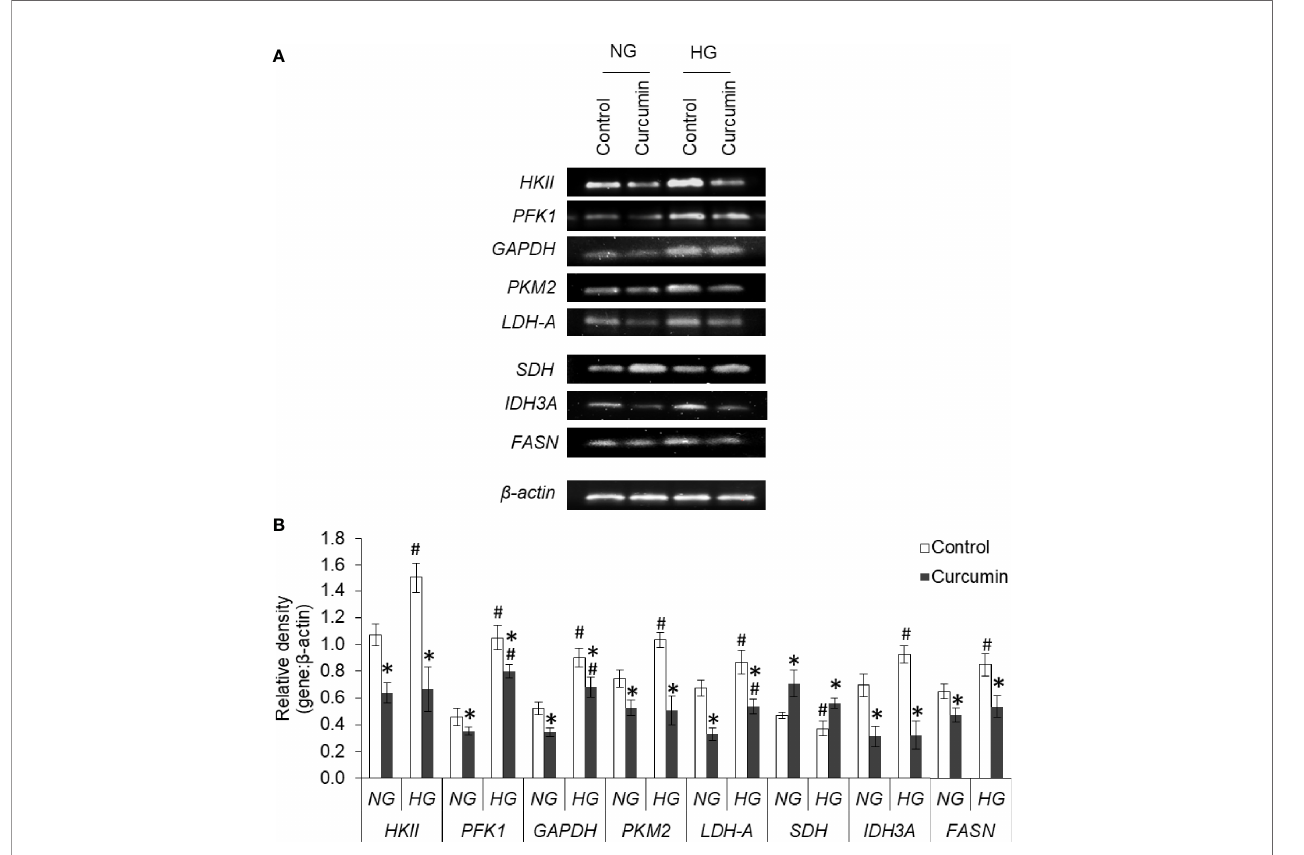
FIGURE 11 | Curcumin modulates the expression of metabolic enzymes. Cells incubated in NG or HG medium with and without curcumin were processed for RT- PCR analysis for gene expression of metabolic enzymes. The ampli fi ed DNA were resolved on Agarose gel, bands were visualized, and images of bands were captured (A) . Densitometric scan of bands were done, and relative intensity of bands against b -actin was calculated (B) . Bands shown are representative of three experiments conducted independently. The values shown are Mean ± SD of three independent experiments conducted in triplicate. * p < 0.05 vs values of cells of control group. # p < 0.05 values of cells incubated in NG